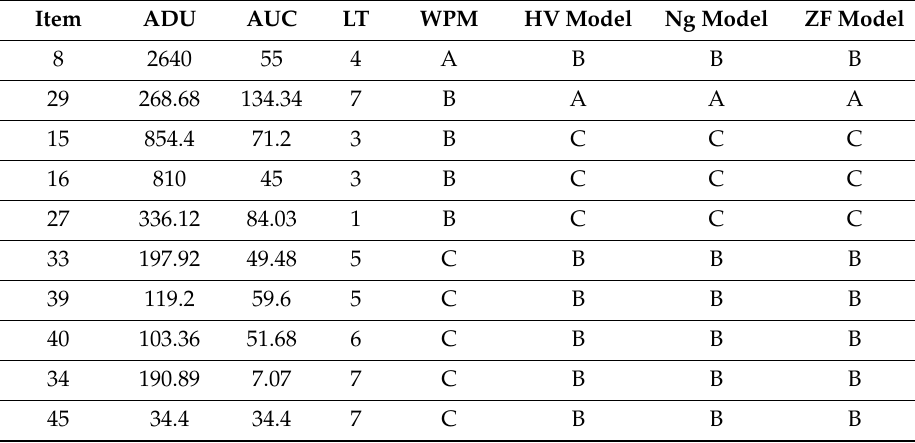
Table 3. The 10 items reclassified using the WPM.